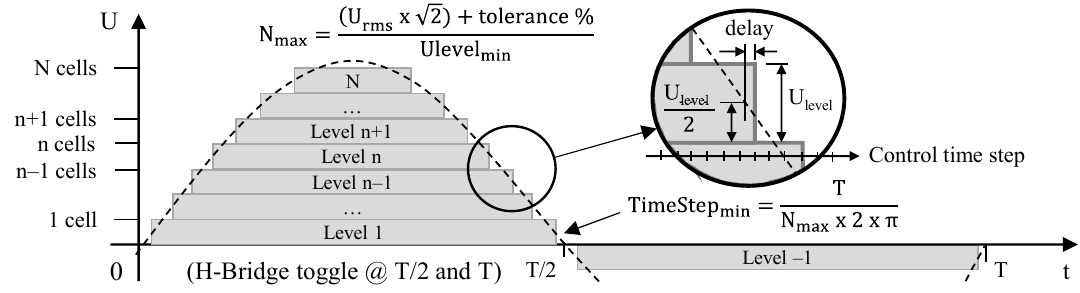
Figure 1. Staircase shape sine waveform generated by N-level self-reconfigurable battery (SRB). When taking EU electrical network voltage as an example, which is 230 VRMS +/ − 10% with a frequency of 50 Hz, and using cells which the specified end of discharge